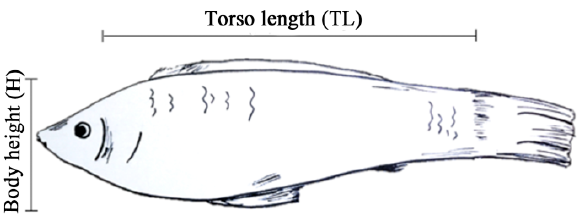
Figure 1. Diagram of the measured body traits.